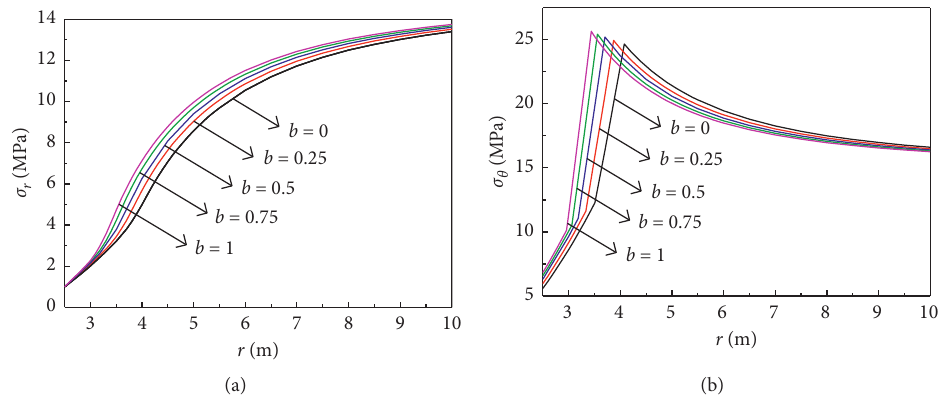
Figure 4: Stresses distribution under different intermediate principal stress coefficients. (a) σ